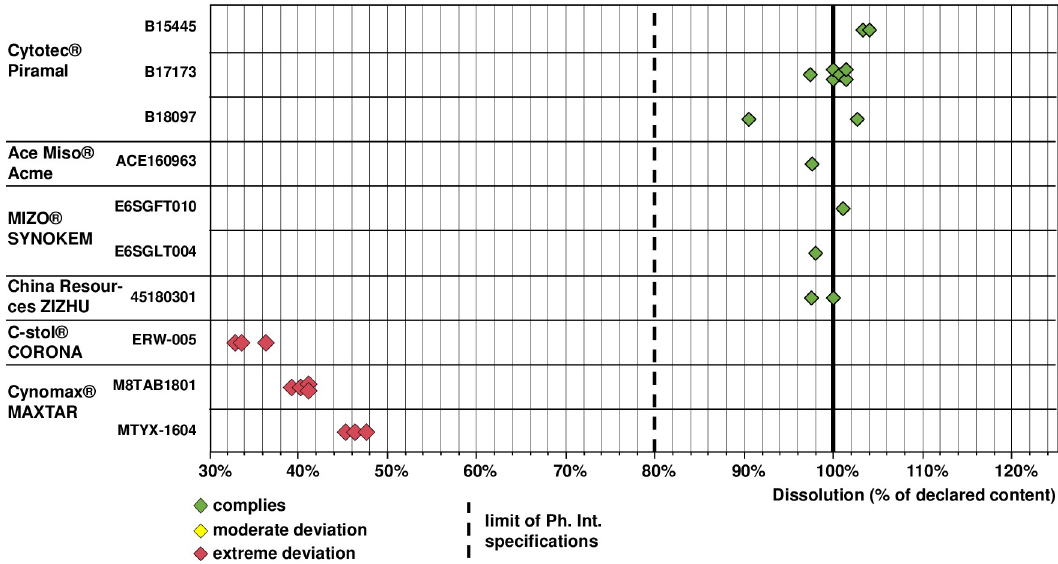
Fig 6. Dissolution of misoprostol determined in each of the investigated